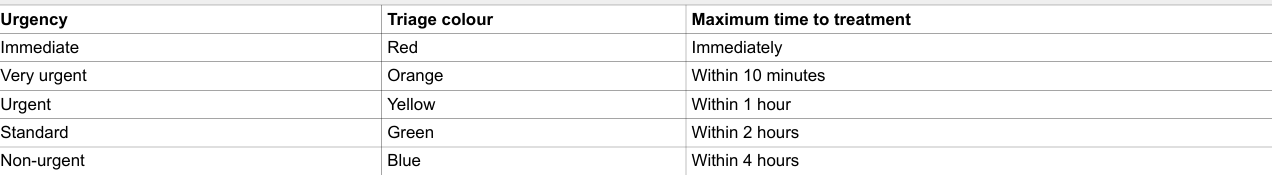
Table 1 Patient treatment priorities according to the Manchester Triage System